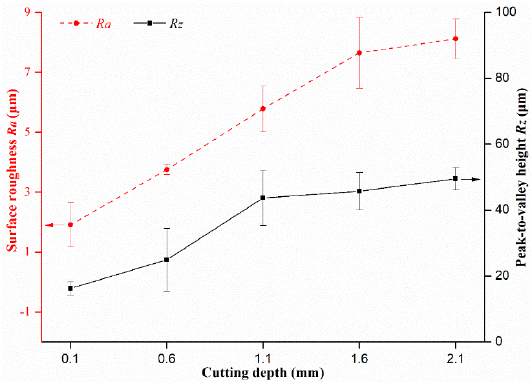
Figure 13. Surface roughness, R a and peak-to-valley height, R z of surfaces machined at different cutting depths; each point is the average of five observations, and the error bars of each data point represent one standard deviation.